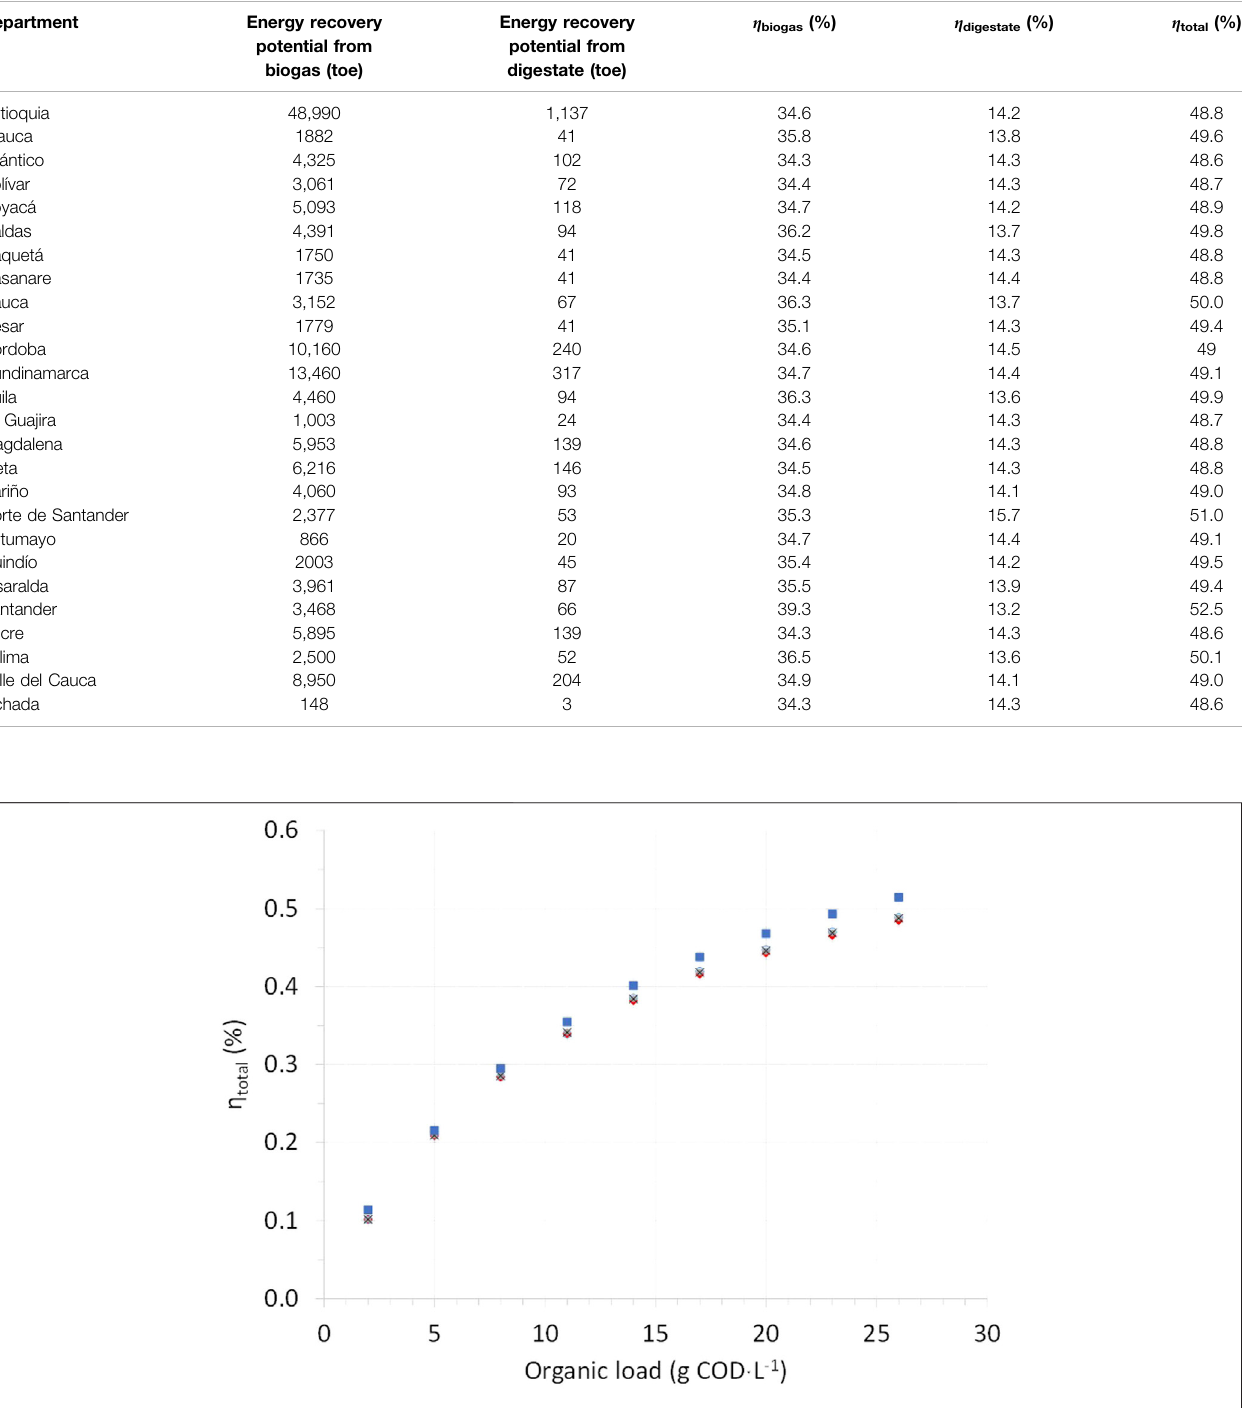
TABLE5| Energyrecoverypotentialfrombiogasanddigestate,energyrecoveryyieldsforbiogasanddigestate,andtotalenergyrecoveryyieldsobtainedbyADFsimulation according to the total availability of CFM, CCM, and SM in 2017 (inlet organic load 26 gCOD · l − 1 ).